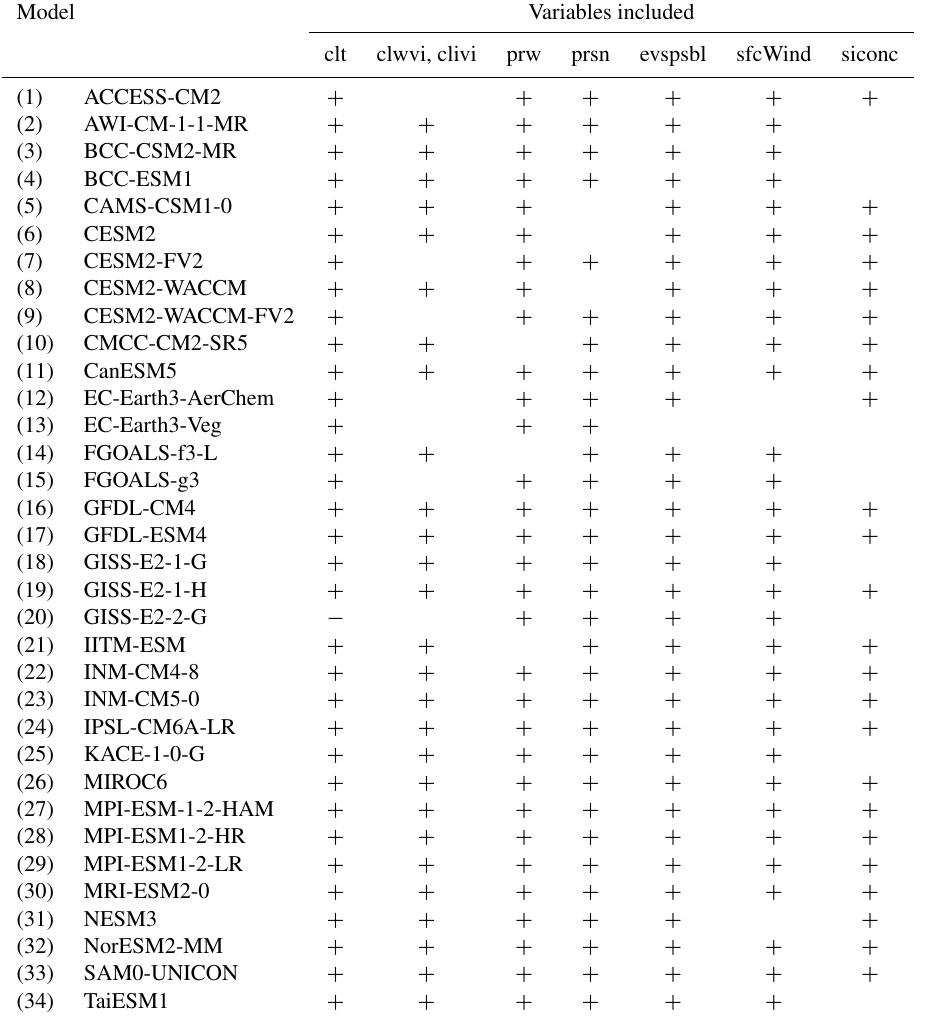
Table A2. Model output coverage in this study. Only variables where output was missing from some models are listed, and all other variables listed in Table A1 that are not present here are fully included in the study. Models where variable output was available for all experiments and presented in the study are marked with a plus sign ( + ), and a dash ( − ) is used where output from historical simulations was missing (only one variable, clt, from one model,